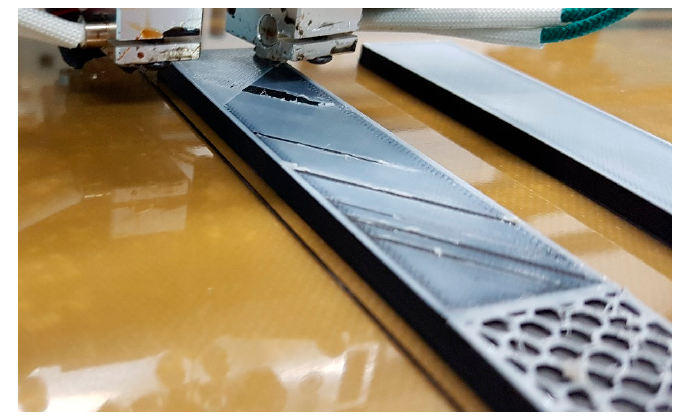
Figure 5. Extrusion problems during manufacturing of specimens due to imprecise leveling.